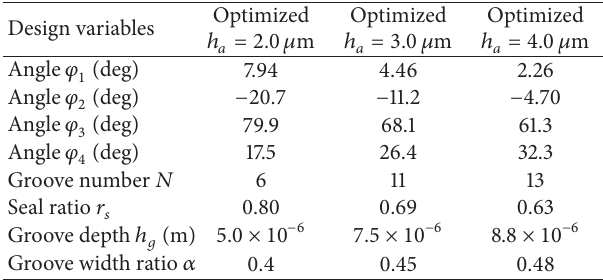
Table 3: Design variables of optimized bearings at 10,000 rpm. Design